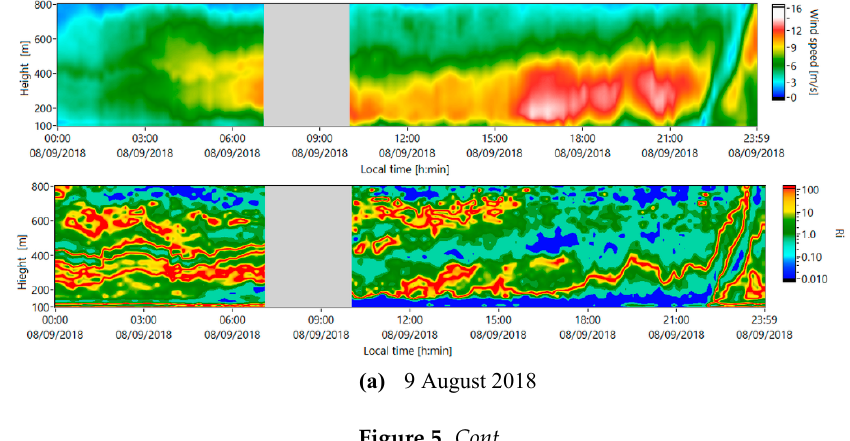
Figure 4. Diurnal variations of the vertical gradients of ( a ) temperature and ( b ) potential temperature averaged for the period of measurements on 6–23 August 2018.